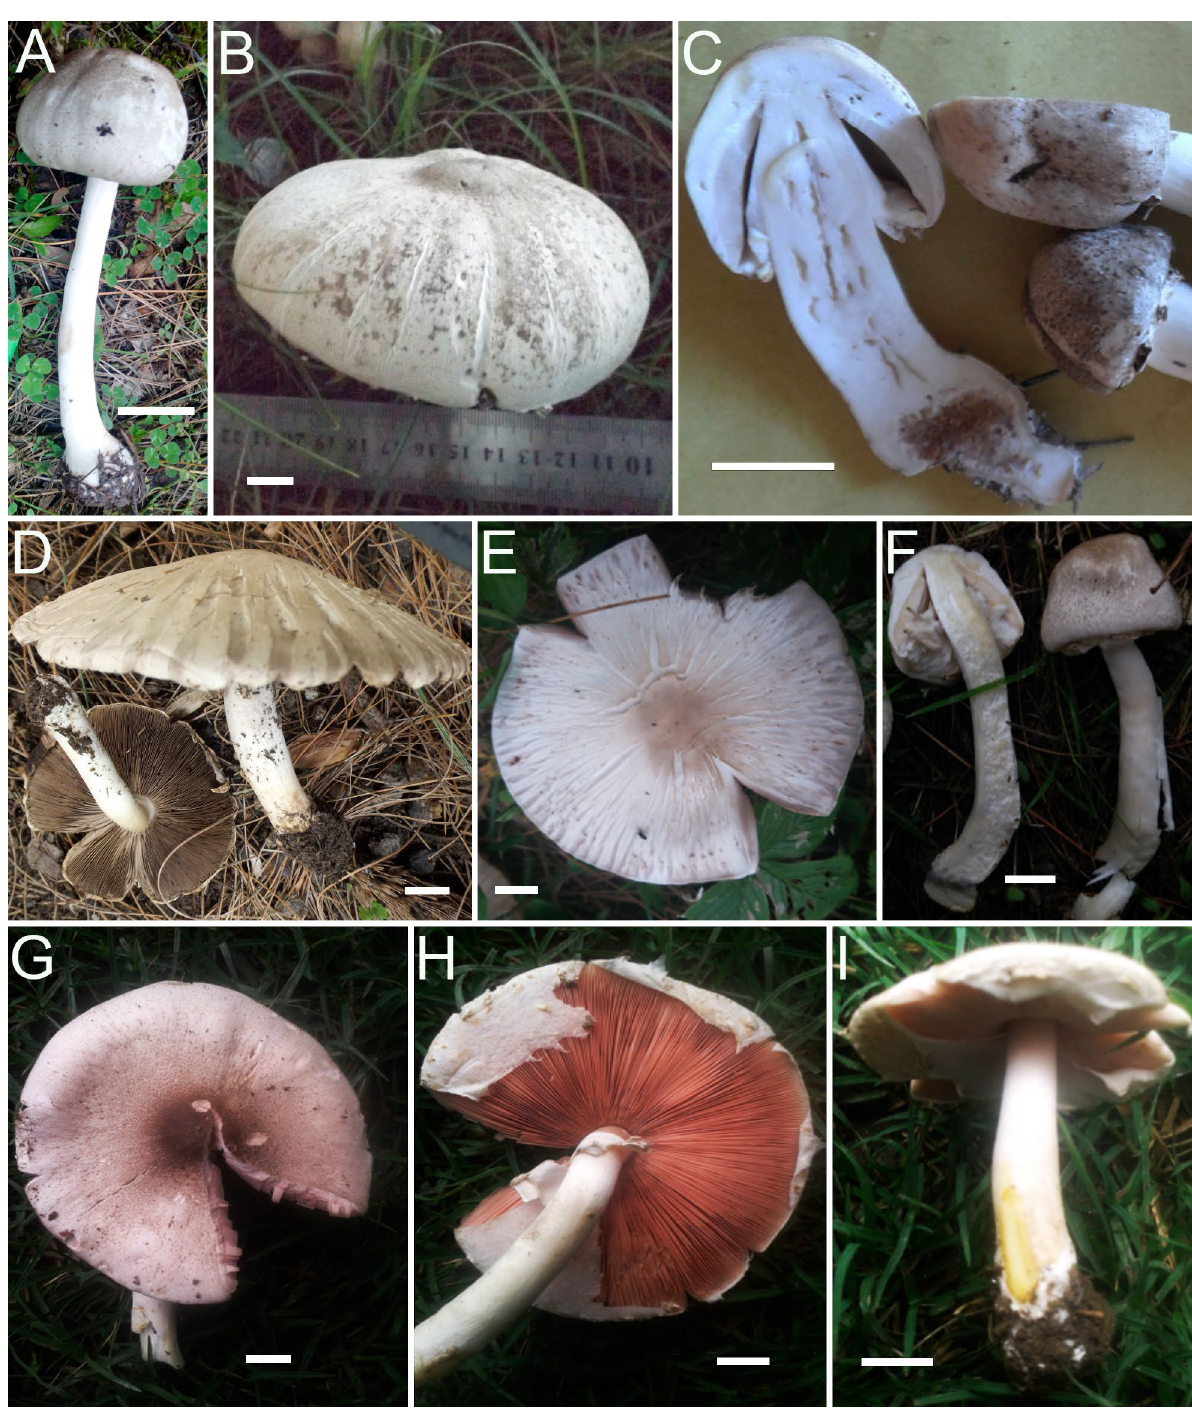
Figure 11. Macromorphological characters of A. griseovariegatus (A–F) and A. macropeplus (G–I) . (A–I) Basidiomata in the field. (A) BG37; (B) SA194; (C) SA850; (D) SA232; (E , F) KH167 ( Holotype ); (G,H) MW1501 ( Holotype ); (I) MW1544. Bars = 1 cm. Photographed by Dr. Hira